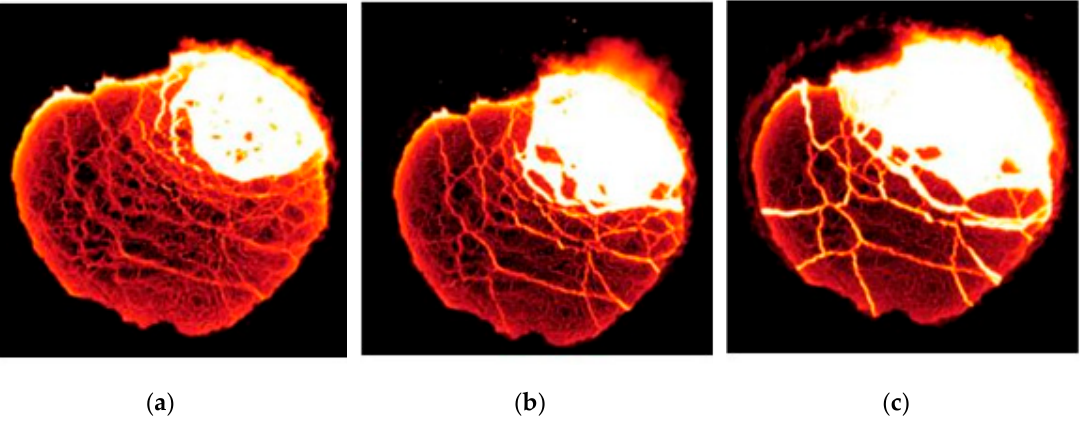
Figure 4. Open-eye size in the ladle from experimental results for a slag layer thickness of 40 cm: ( a ) Q = 200 NL/min, ( b ) Q = 400 NL/min, and ( c ) Q = 500 NL/min.